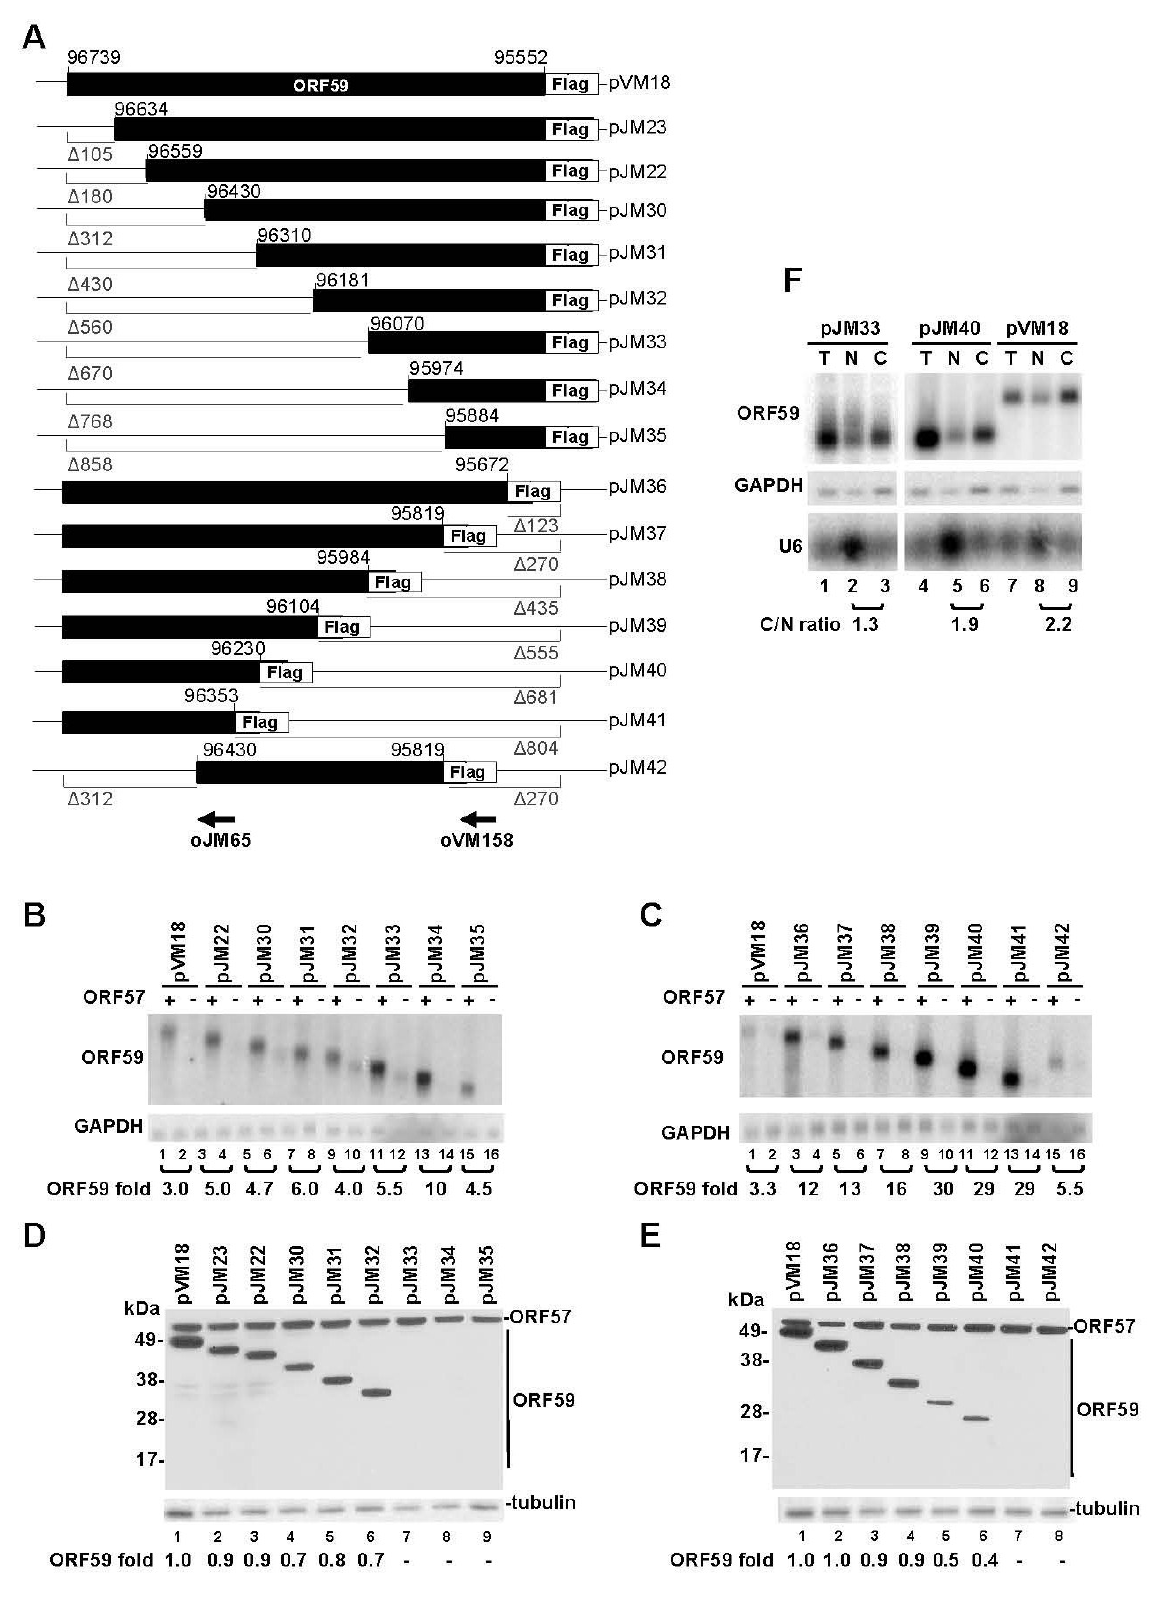
Figure 1. Mapping of ORF57-responsive elements in ORF59 RNA. ( A ) Diagrams of wt ORF59 and its progressive 5’ and 3’ deletion mutants fused in-frame with FLAG-tag on the C-terminus. The size (in nts) of each deletion (Δ) is indicated below the gray line. Numbers above each construct are nt positions in the KSHV genome (GenBank Ac. No.